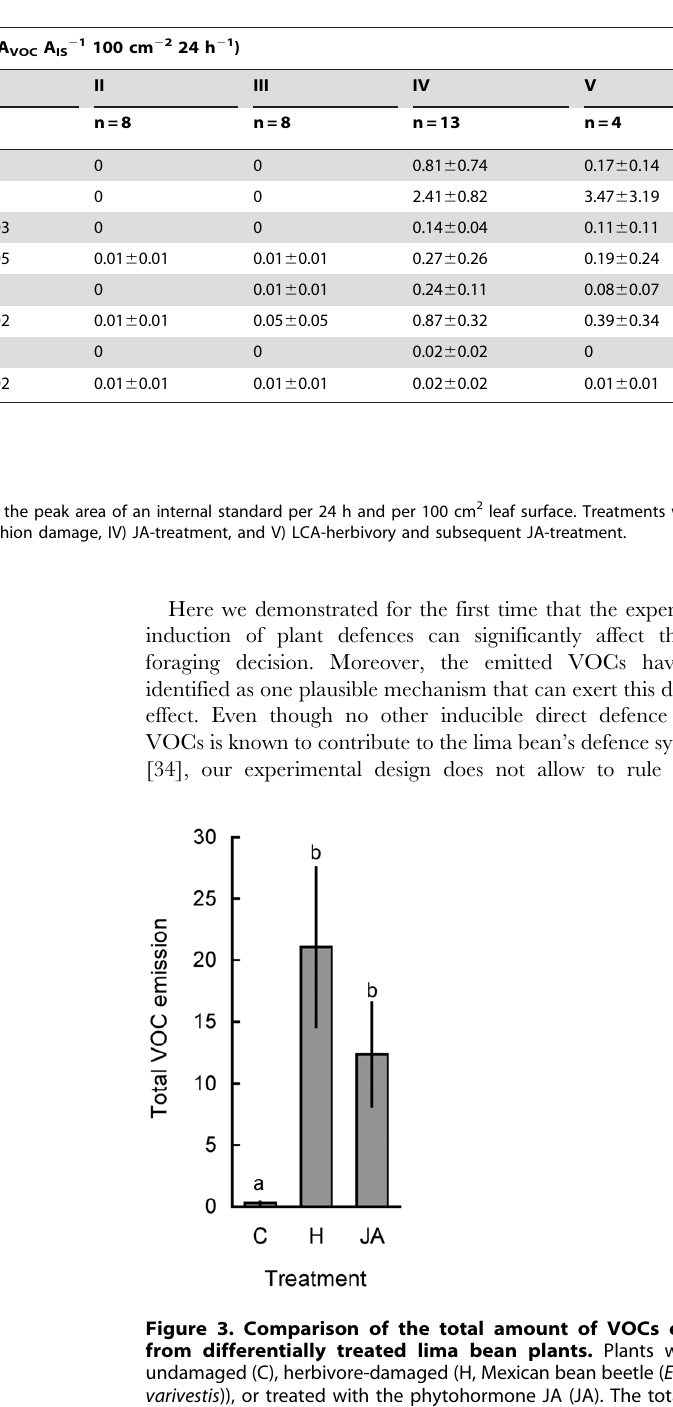
Table 1. Qualitative and quantitative comparison of the VOC profiles emitted from lima bean plants after different treatments.